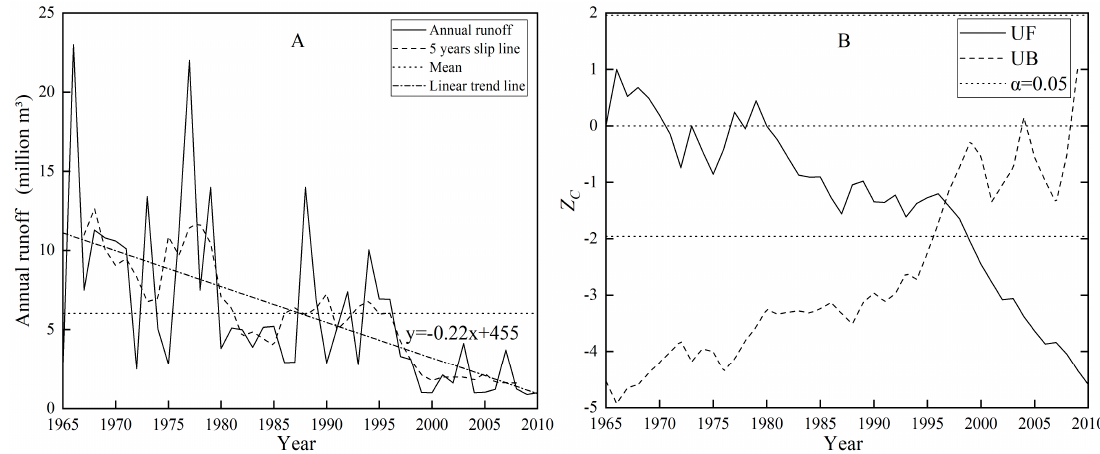
Figure 2. Trend analysis ( A ) and mutation point of annual runoff ( B ) in Gushanchuan basin. Table 4. Variation of meteo-hydrological factors around the mutation point of Gushanchuan basin. Mean Value Variables Z C Significant Variables